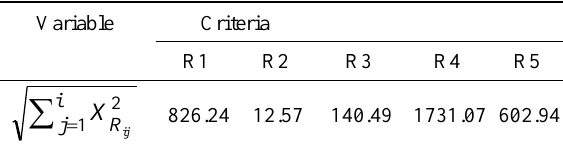
Table 6. Results of denominator value calculations